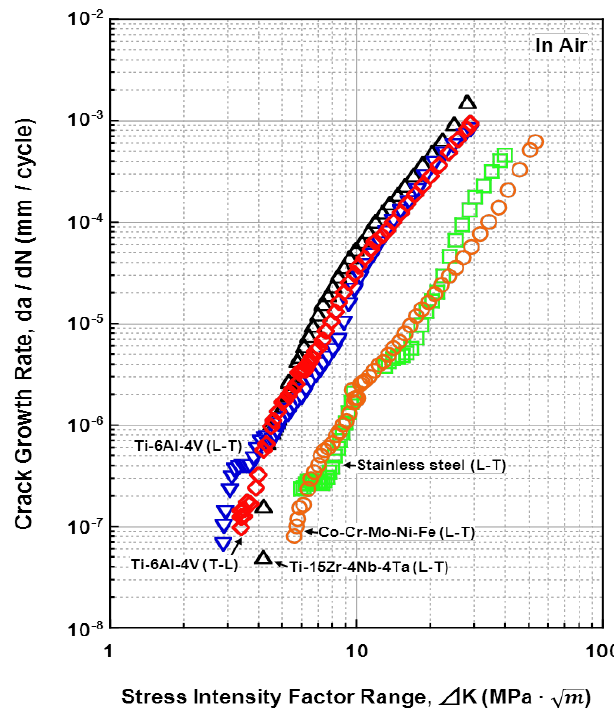
Figure 18. Effects of material on fatigue crack growth rates of specimens cut in L-T and T-L